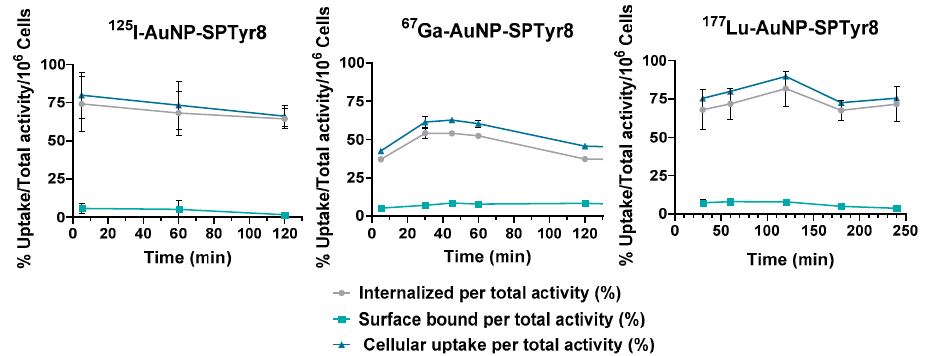
Figure 6. Cellular uptake and internalization of 125 I-, 67 Ga- and 177 Lu-labeled AuNP-SPTyr8 in U373 cells at 37 °C and different incubation times, determined by γ -counting measurements. Results are expressed as the percentage of the total (applied) radioactivity (mean ± SD) and normalized per million of cells.